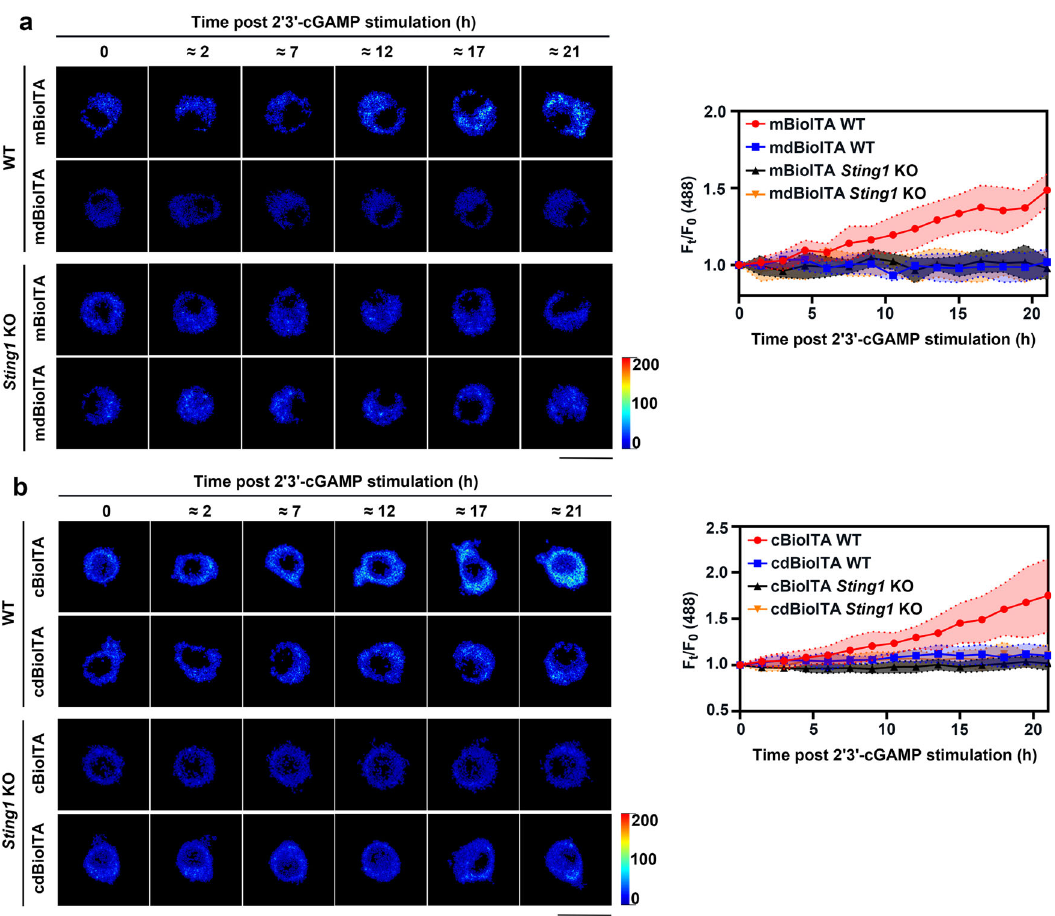
Fig. 5 | BioITA reports itaconate dynamics upon STING activation. a , b Representative pseudo-color images of mitochondrial ( a ) or cytosolic ( b ) BioITAinRAW264.7cellswithoutorwith Sting1 KOwerecapturedatindicatedtime points post 2'3'-cGAMP (10 μ g ml − 1 ) stimulation ( a , b , left panels).Time-dependent fl uorescence intensity of BioITAs or dBioITA in individual cell after 2'3'-cGAMP